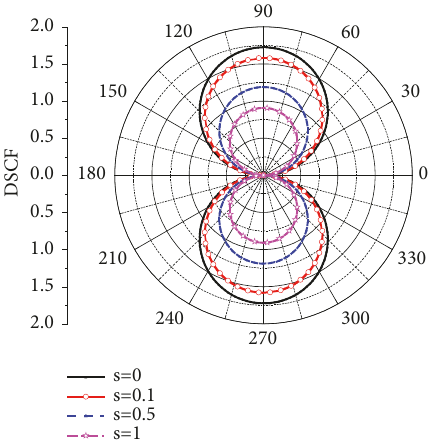
Figure 4: Effect of interface effect on the DSCF with 𝐾 𝐼 /𝐾 = 0.2 .